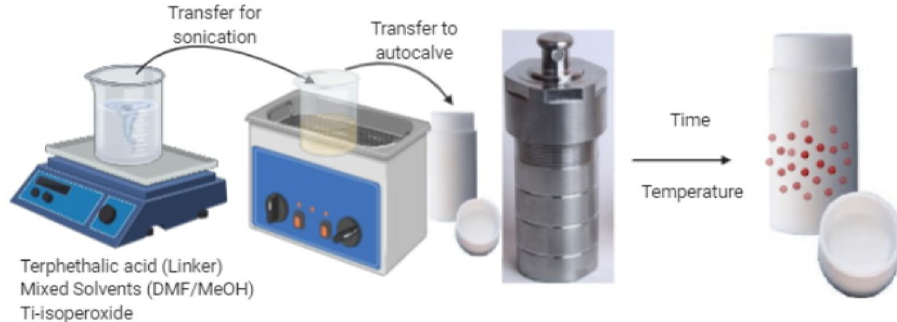
Figure 1. Detailed preparation methods of the solvothermal preparation of